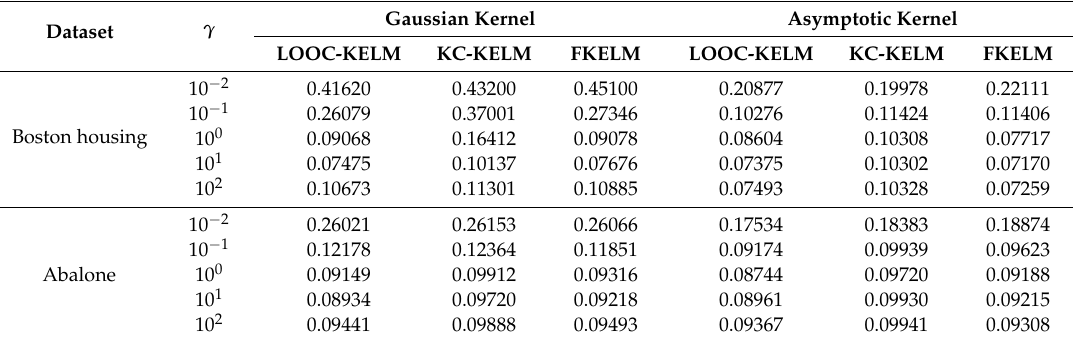
Table 3. The RMSE of various KELMs to benchmark dataset “Boston housing” and “Abalone”.